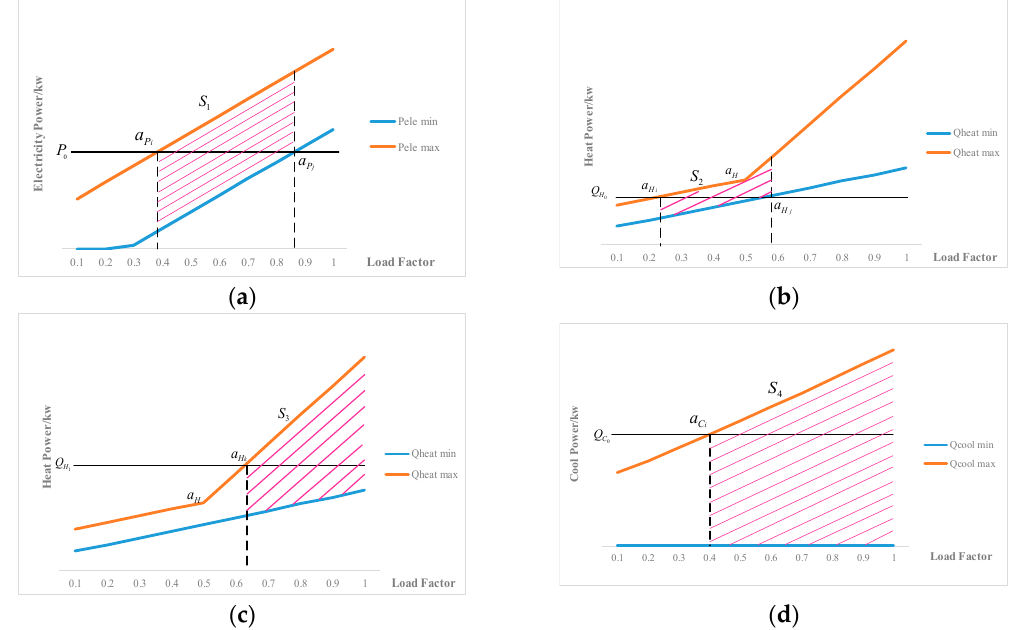
Power-load ratio curves of each decoupling subsystem are obtained.